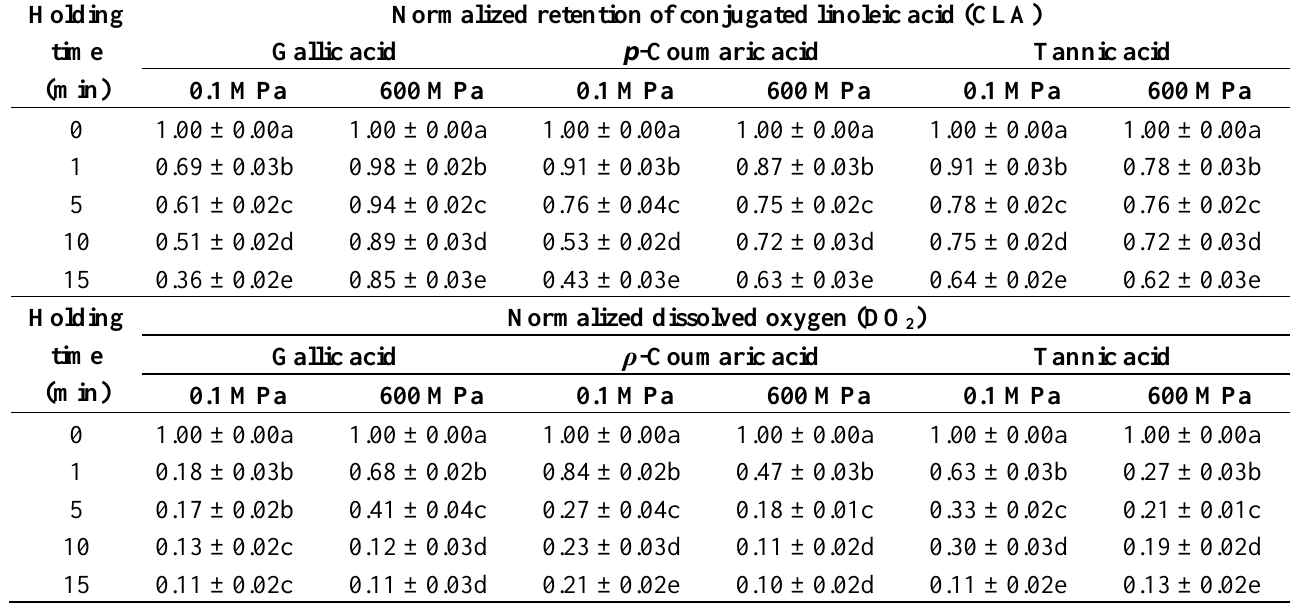
Table 3. Changes in conjugated linoleic acid (CLA) and dissolved oxygen (DO 2 ) in CLA-enriched milk added with either gallic acid, p -coumaric acid or tannic acid and treated at 120 °C and 0.1 or 600